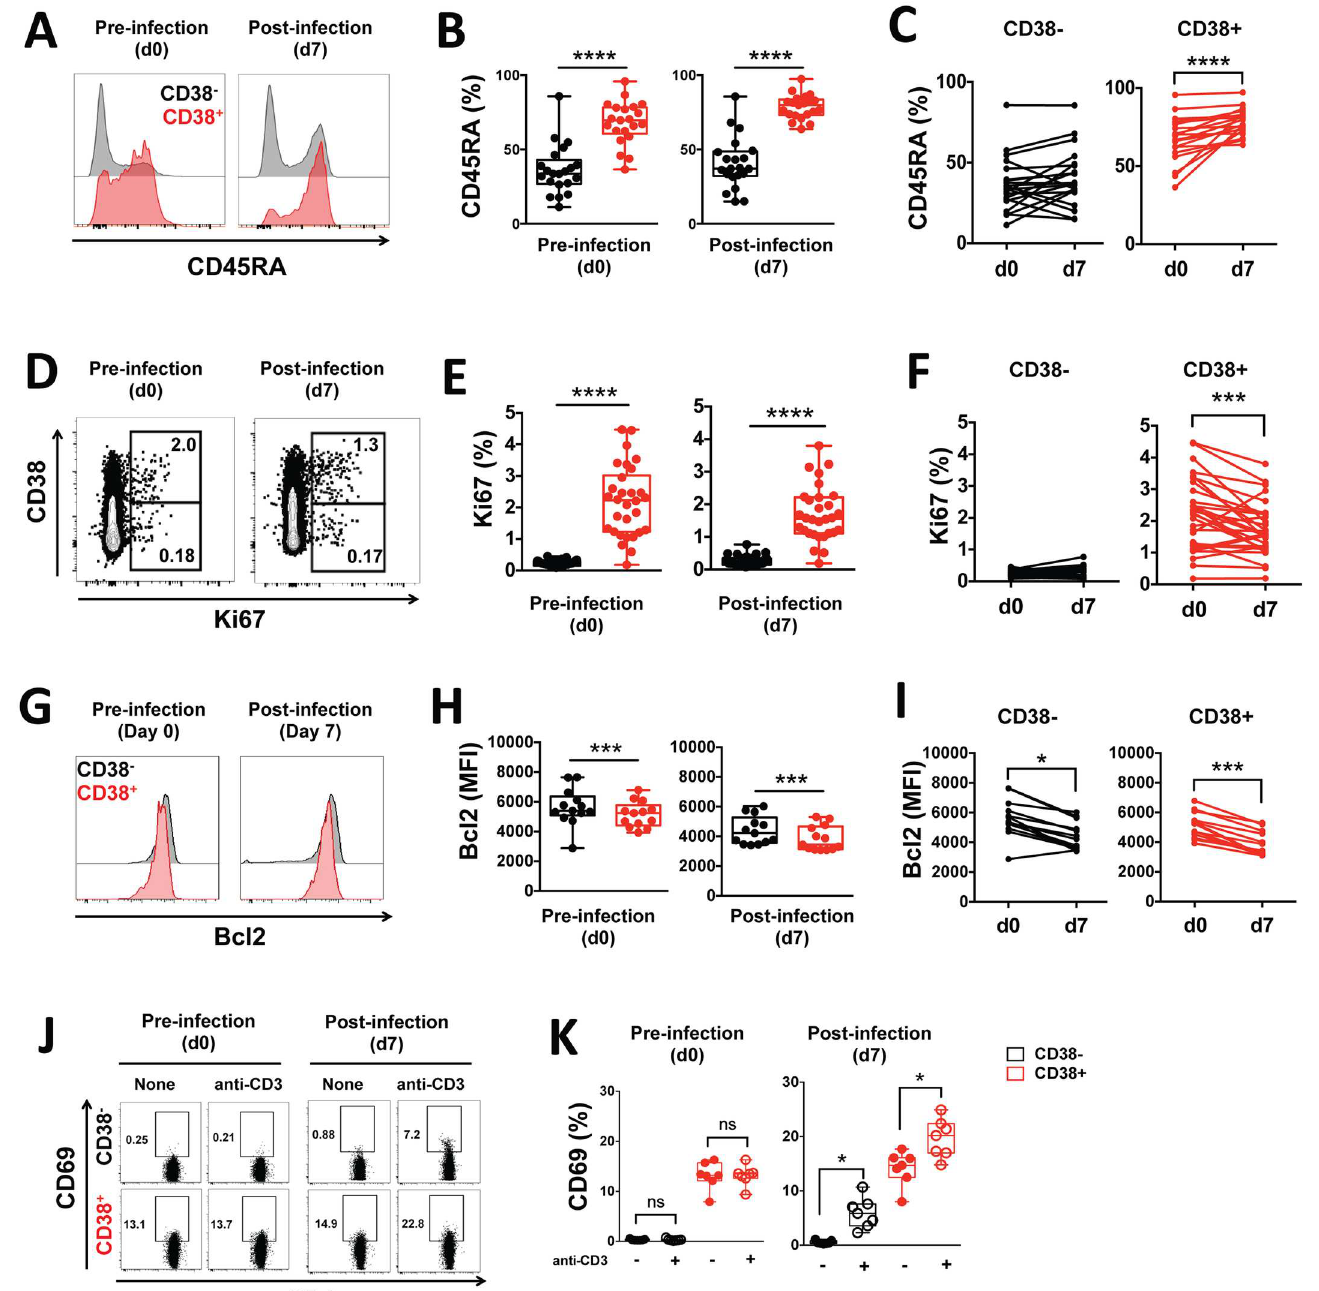
Fig 2. CD38 + CD4 + T cellshave a ‘na ï ve-like’ effectorphenotype associated withproliferation and recentactivation. (A) Representative stainingof one volunteer and (B-C) the frequencies of CD45RA + cells in CD38 - (black) or CD38 + (red)CD4 + T cells determined by flow cytometry in volunteers priorto and seven days post infection. (D) Representative stainingof one volunteer and (E-F) the frequencies of Ki67 + cells in CD38 - (black) or CD38 + (red)CD4 + T cells determined by flow cytometryin volunteers priorto and seven days post infection. (G) Representative stainingof one volunteer and (H-I) the average expression of Bcl2 in CD38 - (black) or CD38 + (red)CD4 + T cells determined by flow cytometryin volunteers prior to and seven days post infection. (J) Representative stainingof one volunteer and (K) the frequencies of CD69 + cells measuredby flow cytometryin CD38 - (black) or CD38 + (red)CD4 + T cells freshlyisolatedfromvolunteers priorto and seven days post infection afterbriefstimulationwith plate- bound anti-human CD3 antibody. Graphs show combineddata from(A-F)22 volunteers fromfive independent cohorts,(G-I)13 volunteers fromtwo independent cohorts,(J-K)seven volunteers fromone cohort.Statistical differences betweenCD38 - and CD38 + CD4 + T cells or betweenpre- and post-infectionwere determined using the non-parametricWilcoxon test;box and whisker plots indicatemedian,interquartilerange and min-max; * , p < 0.05; ** , p < 0.01; *** , p < 0.001; **** , p < 0.0001ns, p > 0.05.